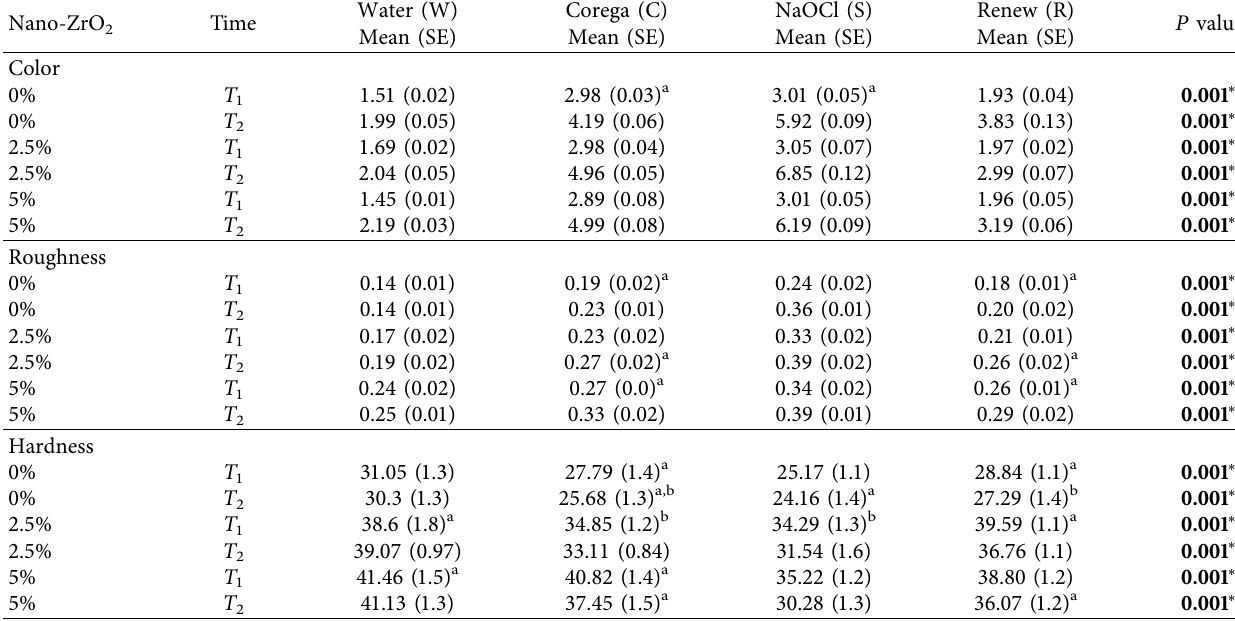
Table 2: Mean and SD values of color ( Δ E ), surface roughness ( μ m), and Hardness (VHN) of acrylic specimens immersed in different solutions at a given time and concentration.